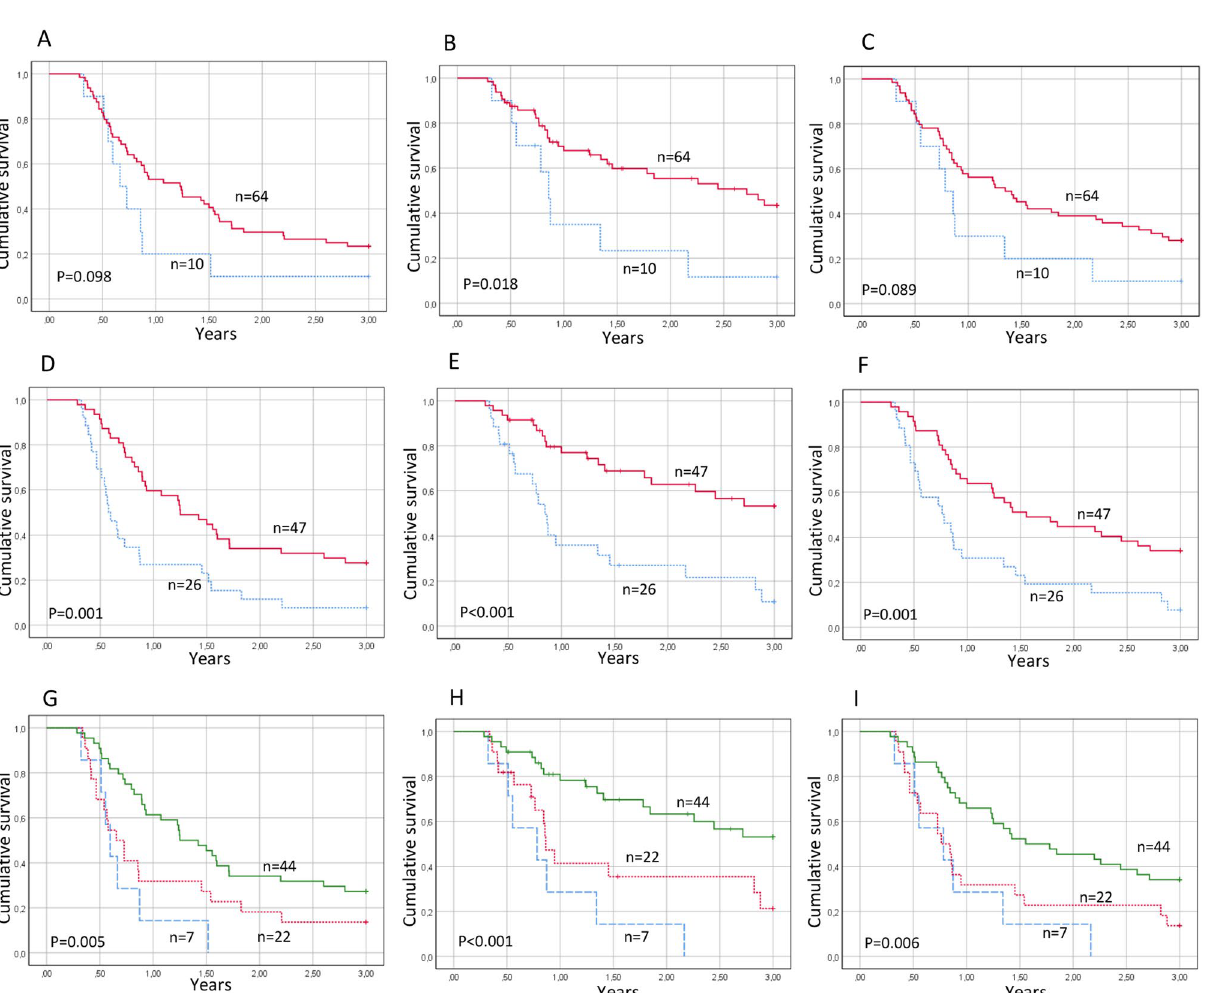
Figure 4. Kaplan–Meier curves presenting progression free ( A , D , G ), disease free ( B , E , H ) and overall survival ( C , E , I ) for patients with HPV-negative HPSCC in relation to S100A12 or HLA class I expression. ( A – C ) S100A12 expression dichotomized between fraction of positive cells more (red) or less (blue) than 33%. (D-F) HLA class I expression dichotomized between absent/low (blue) and medium/high (red). ( G – I ) Combined expression of S100A12 and HLA class I. Both high (green), one high, one low (red) or both low (blue). Notches denotes